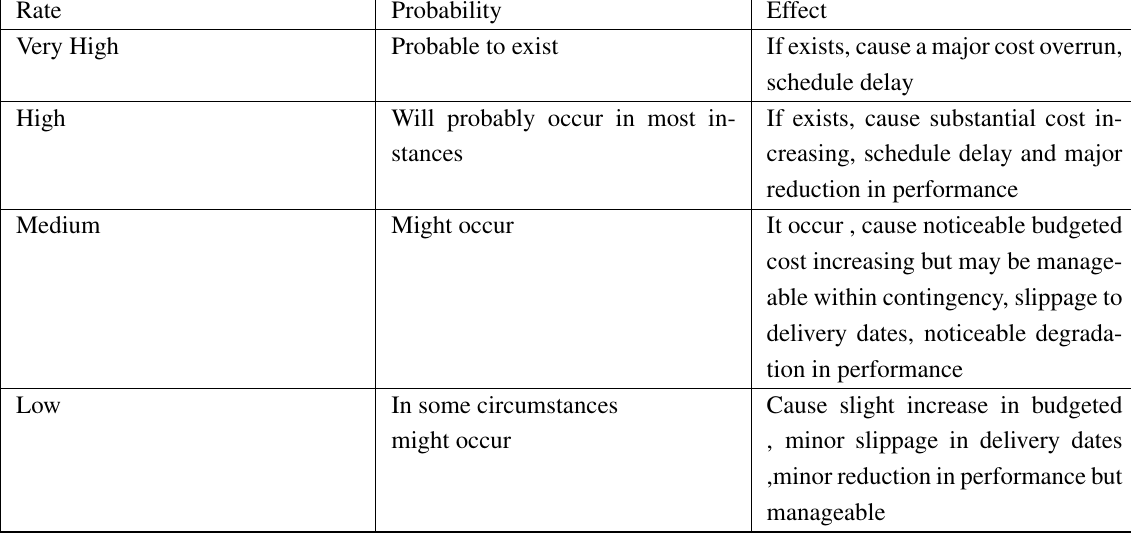
Table 1. Risk effect